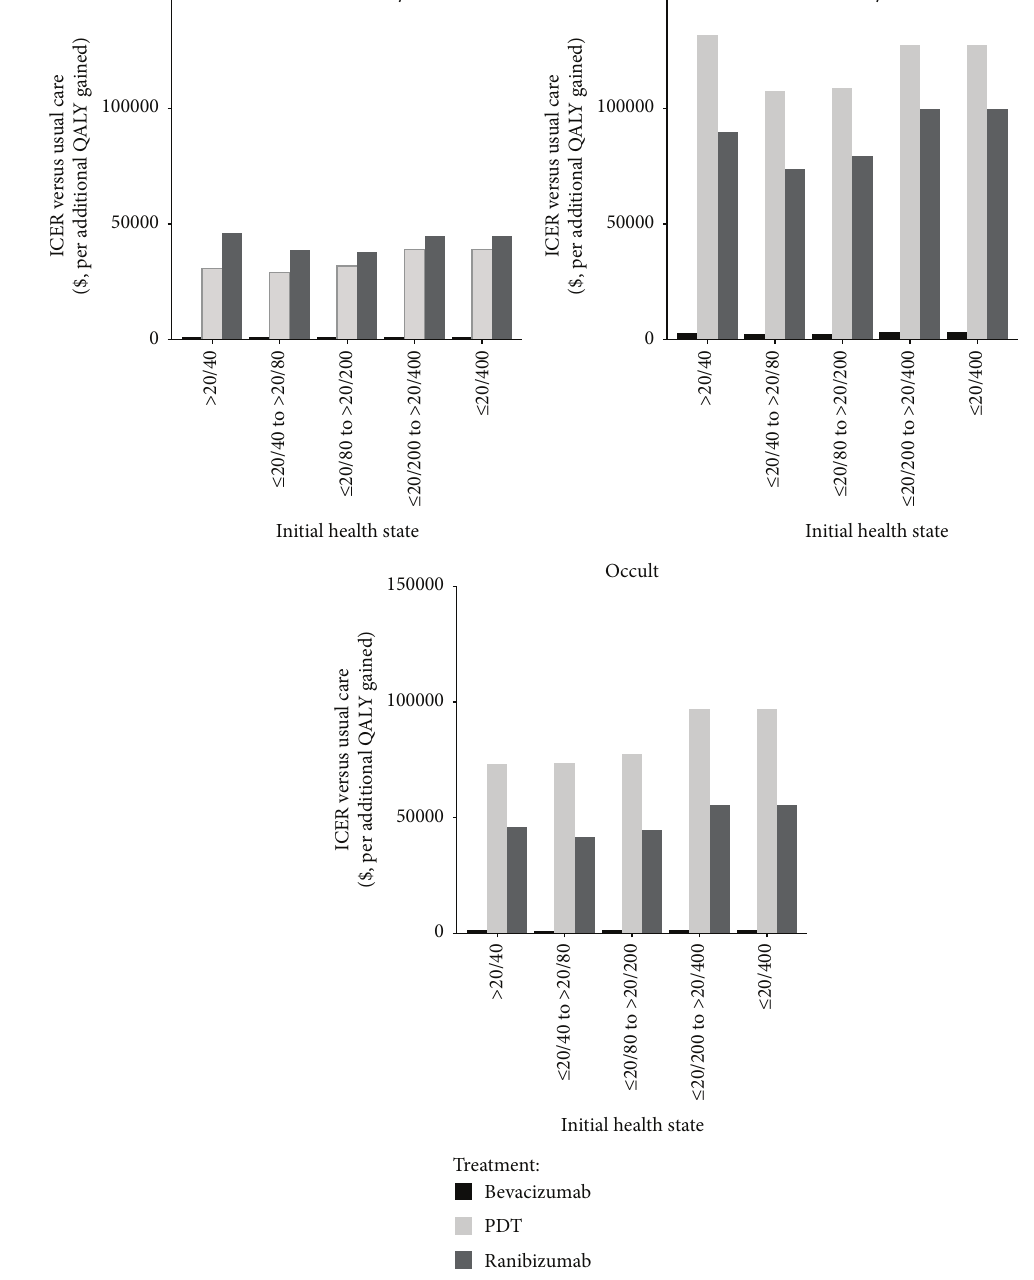
Figure 2: Sensitivity analysis of the effects of the initial health states. Values are indicated ( 𝑦 -axis) as cost per additional quality-adjusted life-year (QALY)